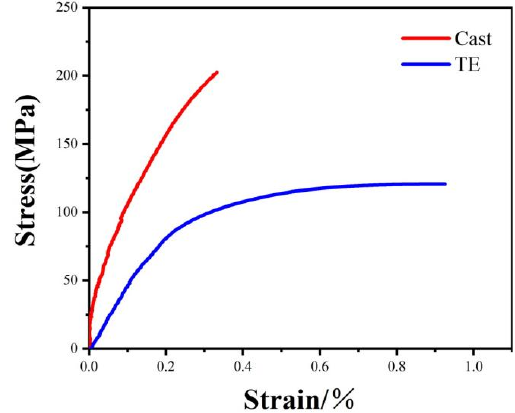
Figure 6. The typical stress–strain curves of Al-Si-Cu-Ni-Mg alloy under different conditions measured at 250 °C (TE represents thermal exposure at 250 °C for 200 h).